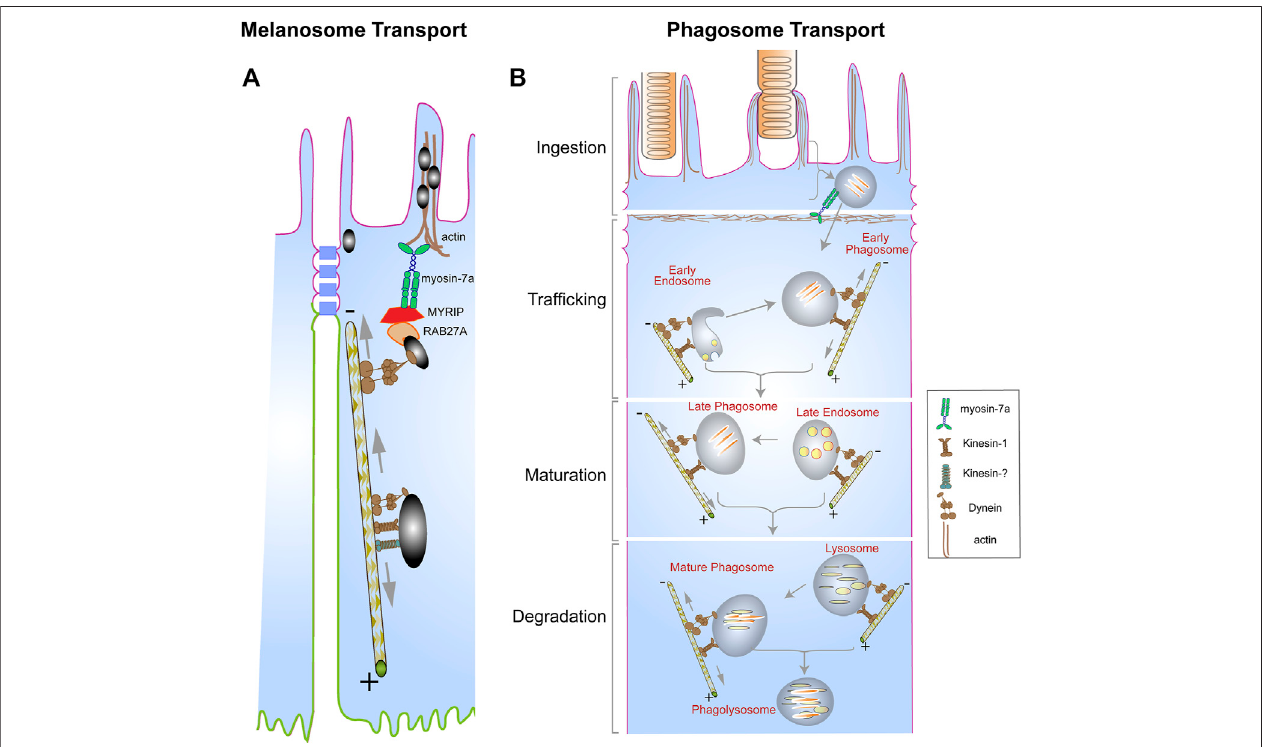
FIGURE2| OrganelletransportintheRPE. (A) Pigment-containingmelanosomes foundintheRPEcellbodyexhibitbidirectional movementsonmicrotubulesdue to the opposing actions of dynein, and kinesin-1, plus possibly a second different kinesin. The traf fi cking of the melanosomes by dynein towards the apical region is necessary for their capture by the actin-based motor, myosin-7a, in complex with RAB27A and MYRIP, resulting in their localization in the actin-rich apical region of the RPE. (B) Photoreceptor outer segment (POS) disk membranes ingested by the RPE form a motile organelle, the phagosome, which undergoes a series of interactions with endosomes (early and late) and lysosomes to ensure timely degradation and clearance. These interactions are facilitated by the opposing actions of dynein and kinesin motors, which mediate the bidirectional movement of the phagosomes, endosomes, and the lysosomes. Although the kinesin and dynein motors appear farapartonaparticularorganelleinboth (A,B) ,theymaybeinacomplexthatassociateswiththecargo via sharedadaptor proteins(Fentonetal.,2021).Several alternative mechanisms have been proposed to drive bidirectional movements of organelles, including coordination between the kinesin and dynein motors that